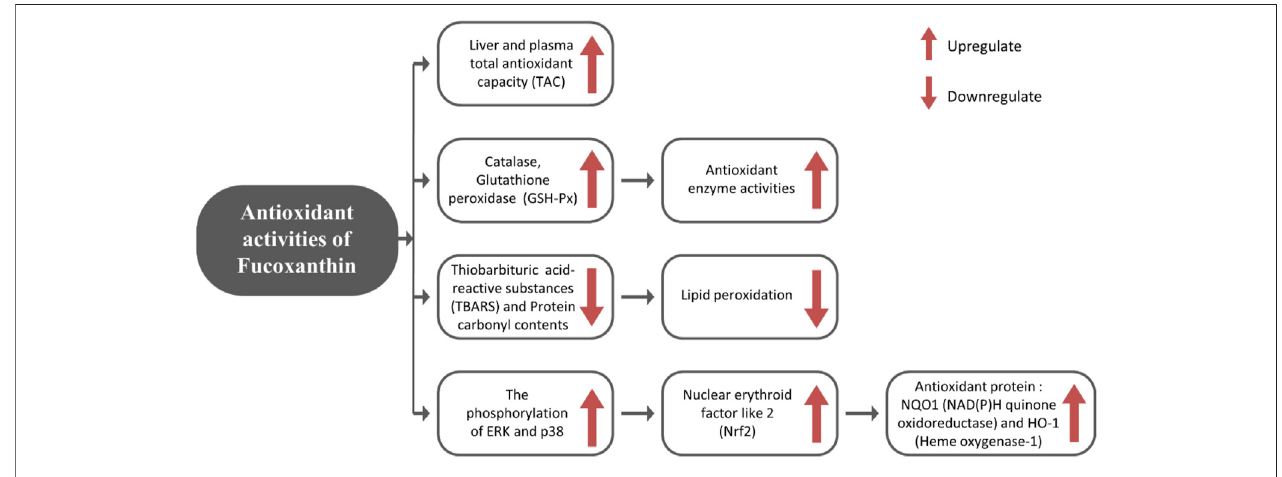
FIGURE 1 | Role of dietary FX in antioxidant